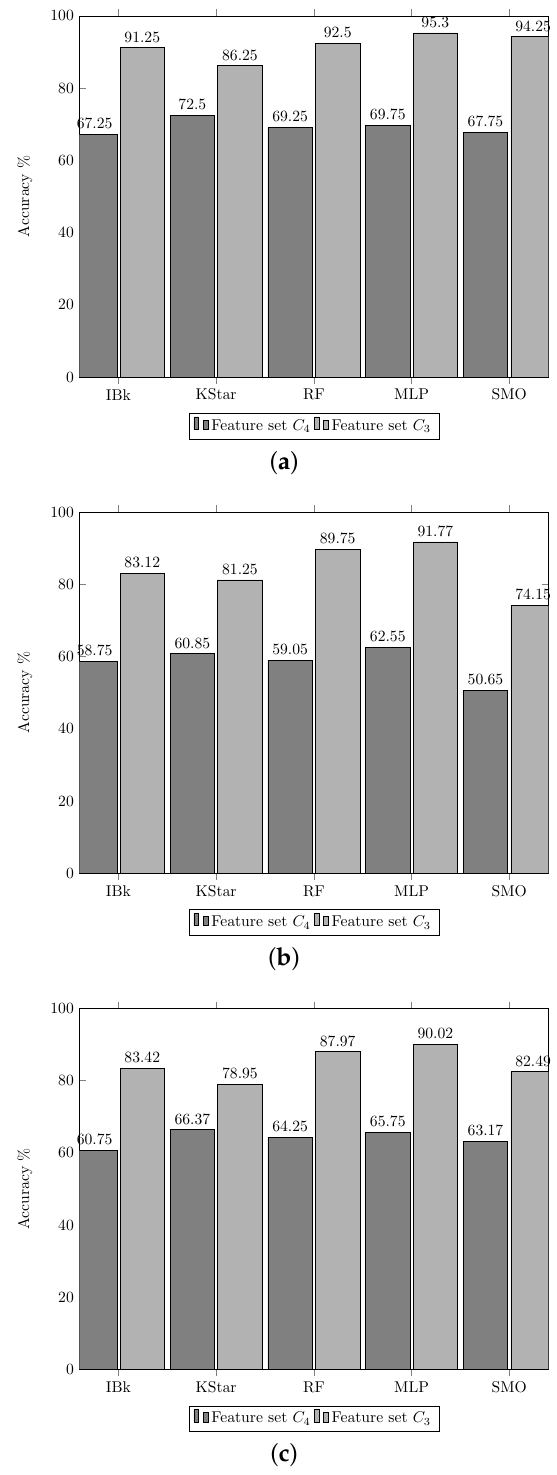
Figure 10. Experiment 3. Post-classification using the q 4 architecture. ( a ) Multi-class group 1, conformed by chromosomes 1 to 5. ( b ) Multi-class group 2, conformed by chromosomes 7 to 15. ( c ) Multi-class group 3, conformed by chromosomes 16 to